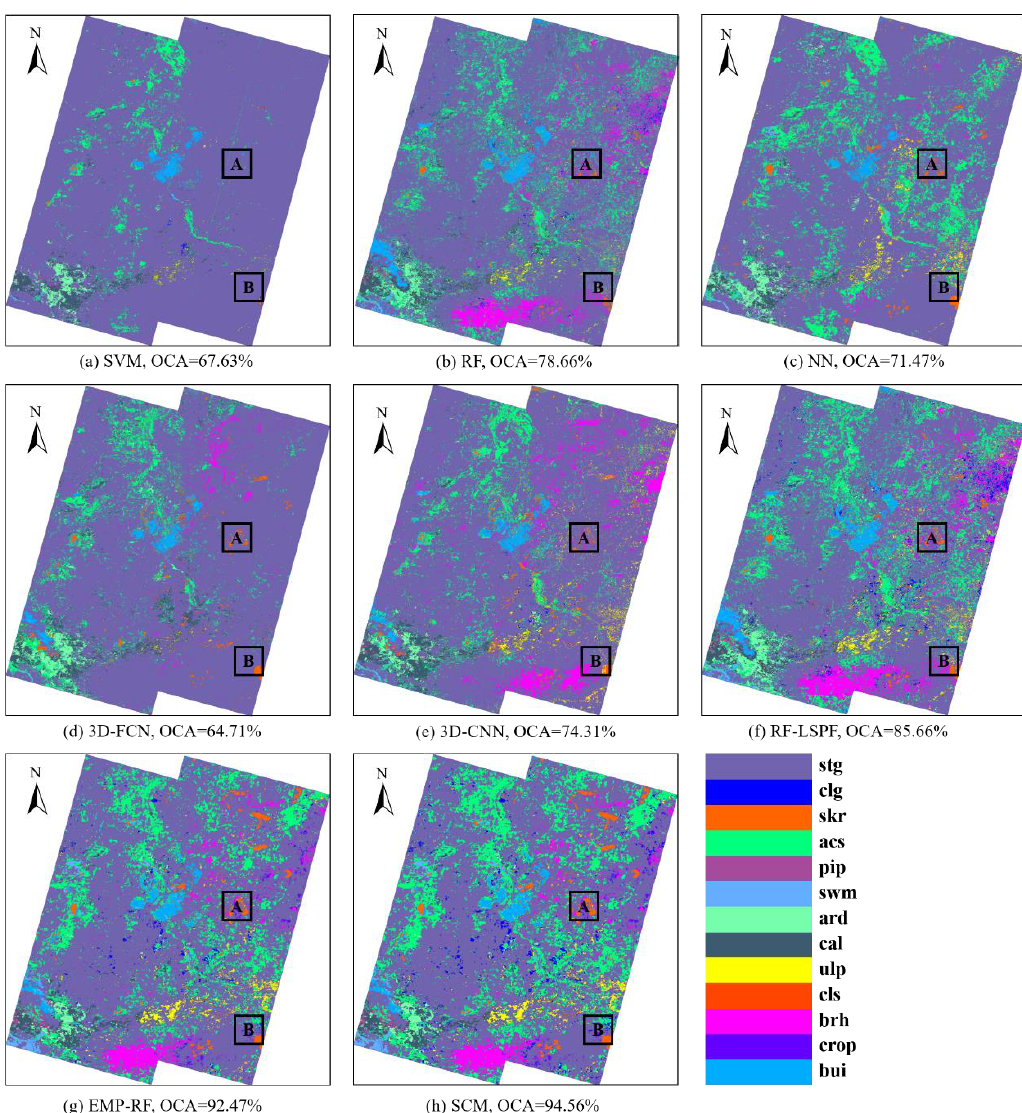
Figure 4. Classification maps obtained using different methods for the Xilinhot Grassland with the corresponding OCA. ( a – h ) represent the classification results of SVM, RF, NN, 3D-FCN, 3D-CNN, RF-LSPF, EMP-RF, SCM methods, respectively. Areas A and B will be described in detail in Section 4.3.